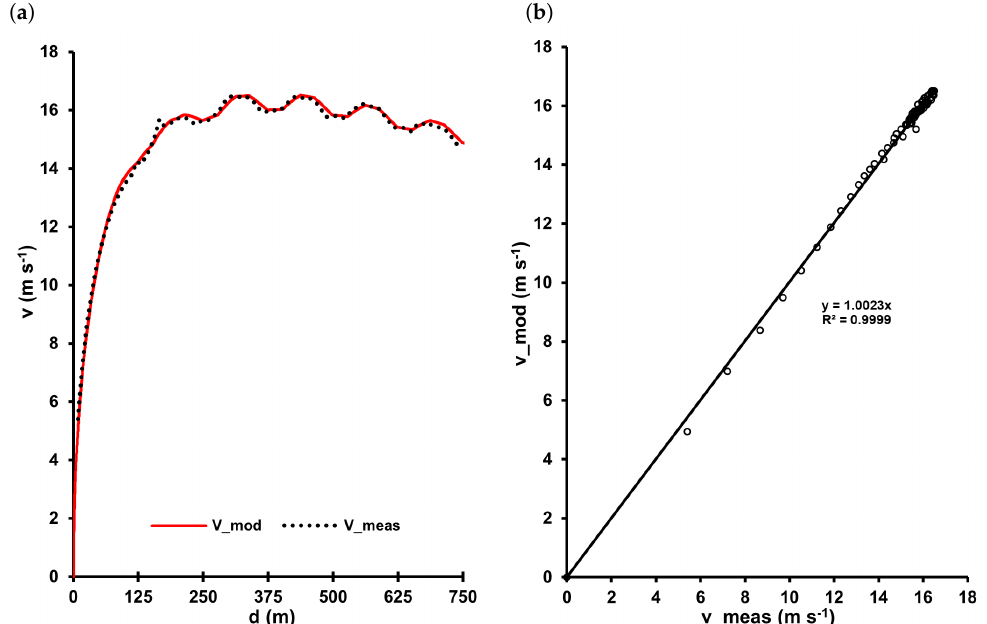
Figure 7. Comparison of the measured and modelled velocity v w in the second run of a 750 m-time trial. ( a ) Measured and modelled data, ( b ) linear regression